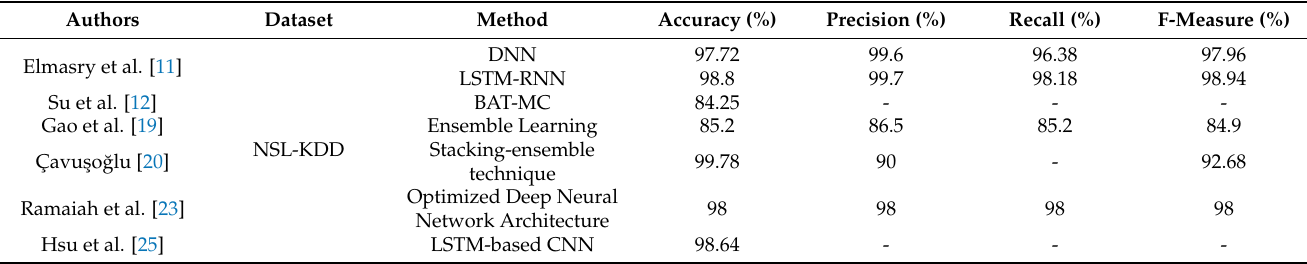
Table 5. Comparative